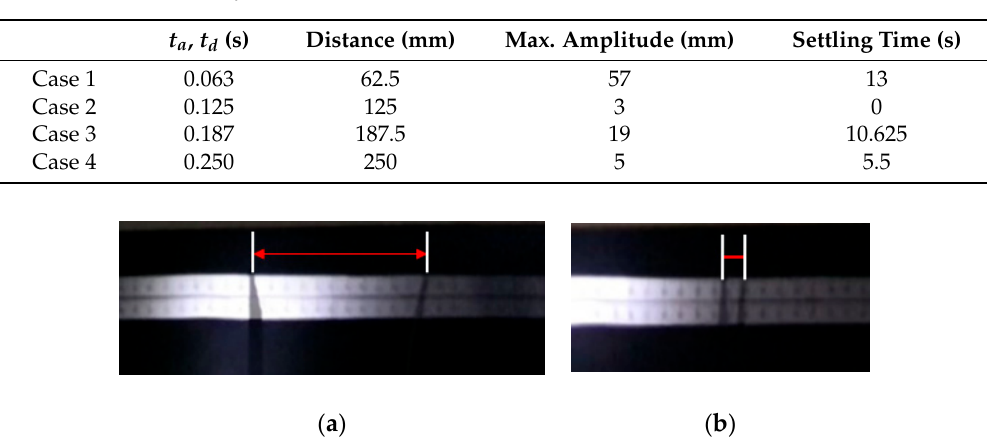
Figure 22. Position deviations at target: ( a ) when 𝑡 (cid:3028) = 0.063 ; ( b ) when 𝑡 (cid:3028) = 0.250 .